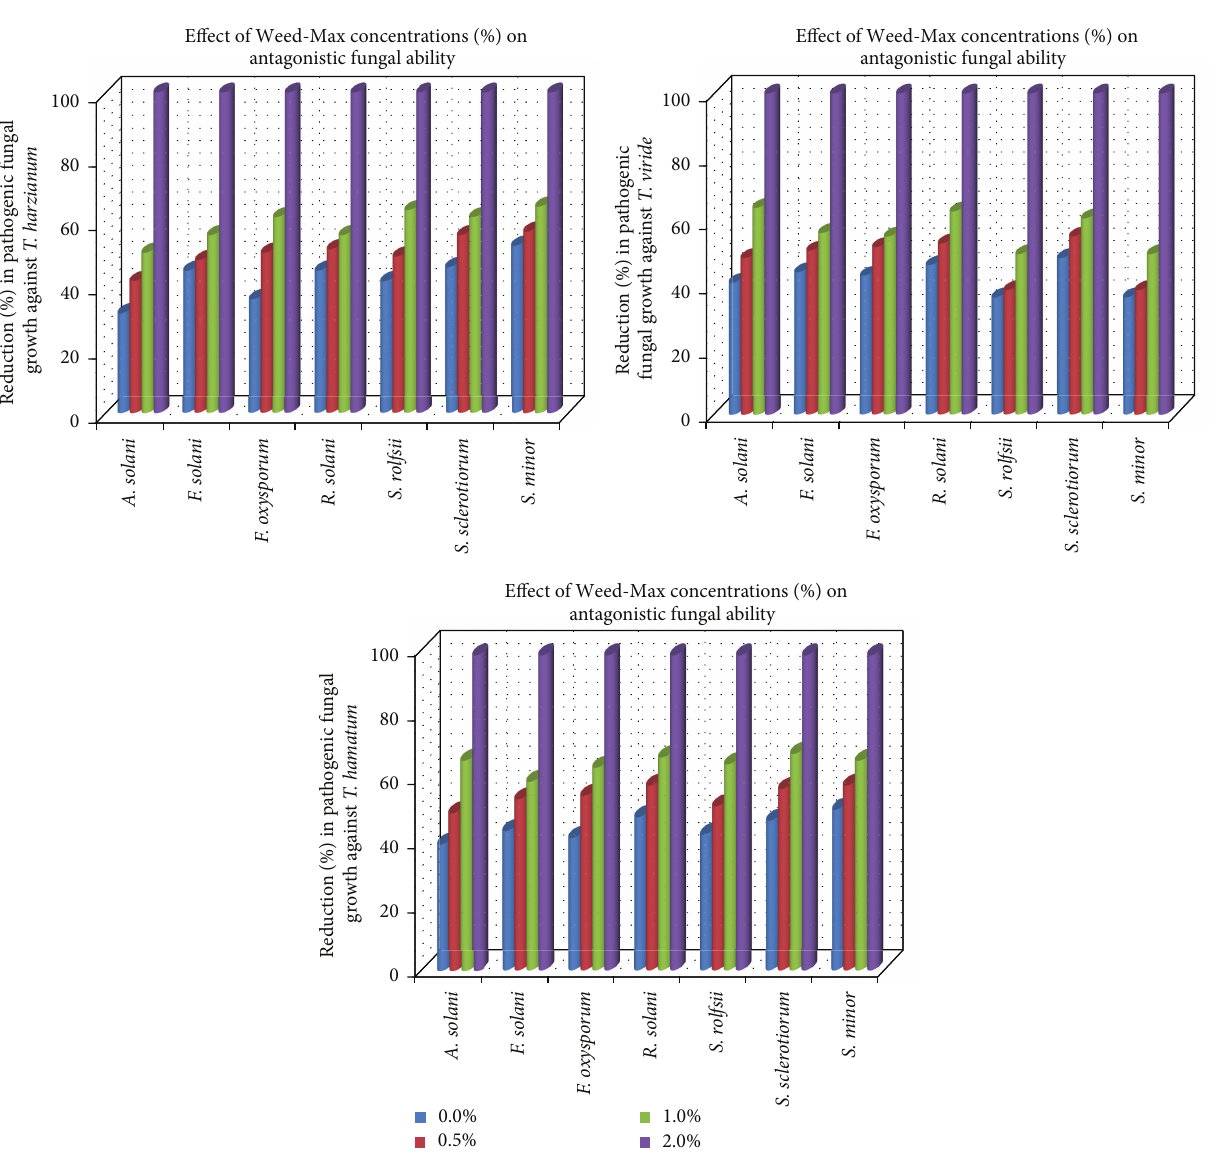
Figure 1: Reduction (%) in pathogenic fungal growth against Trichoderma spp. in medium supplemented with Weed-Max at different con- centrations in vitro